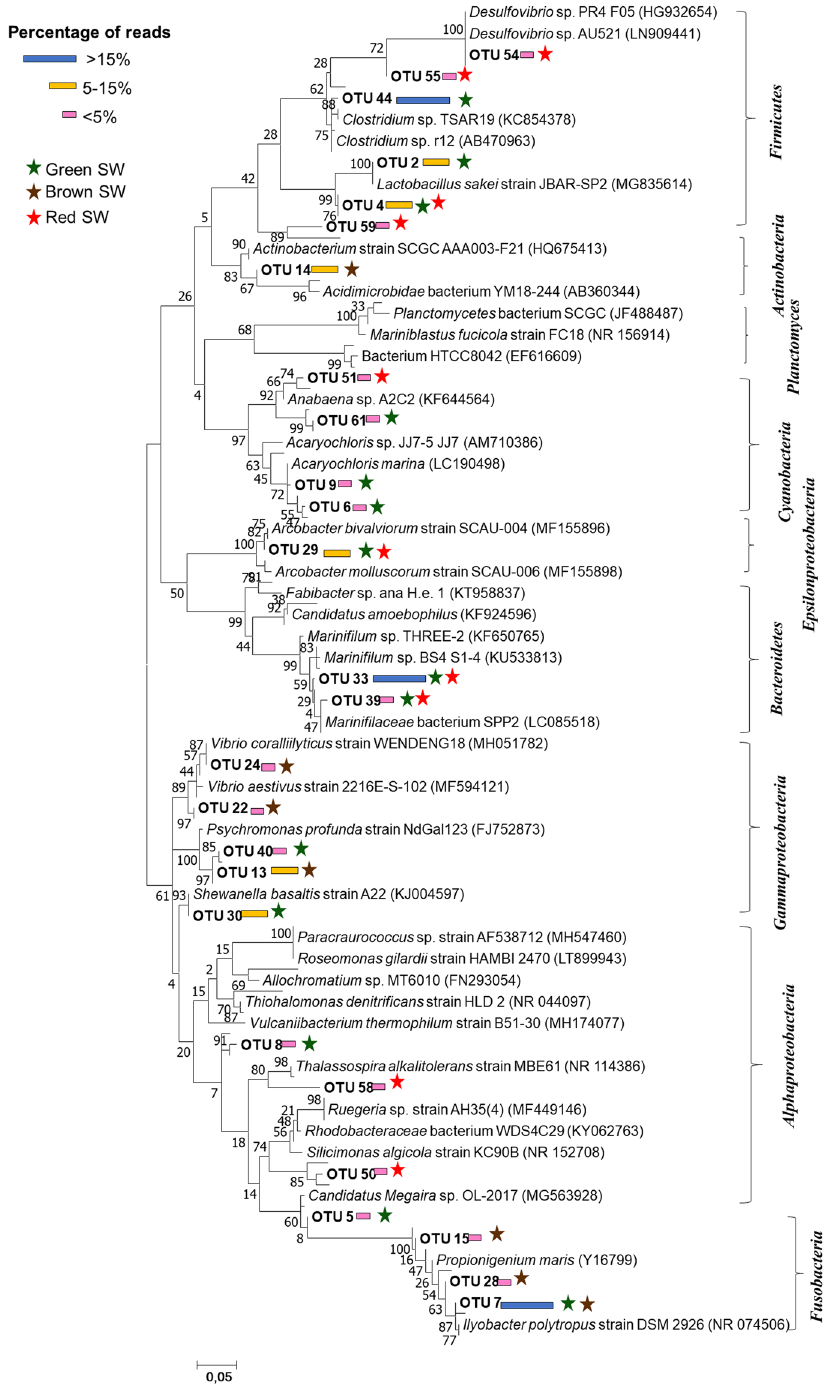
Figure 3. Maximum-Likelihood phylogenetic tree showing the 16S rRNA gene sequences of top 10 OTUs observed in the eight different seaweeds. Bootstrap values are given in percentage at branch nodes based on 1000 resembling. The scale bar indicates evolutionary